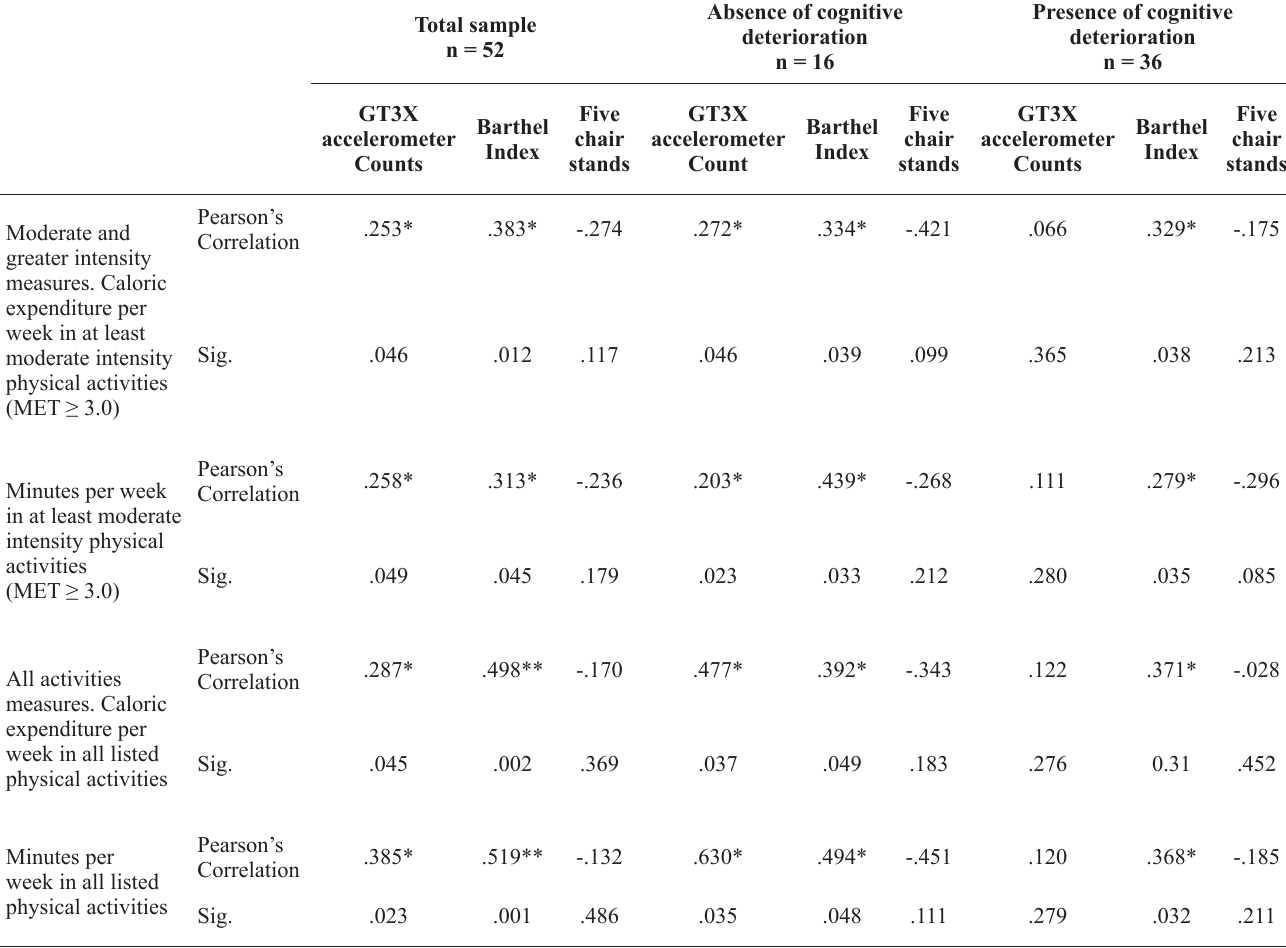
Table 2 Correlations established between the variables under